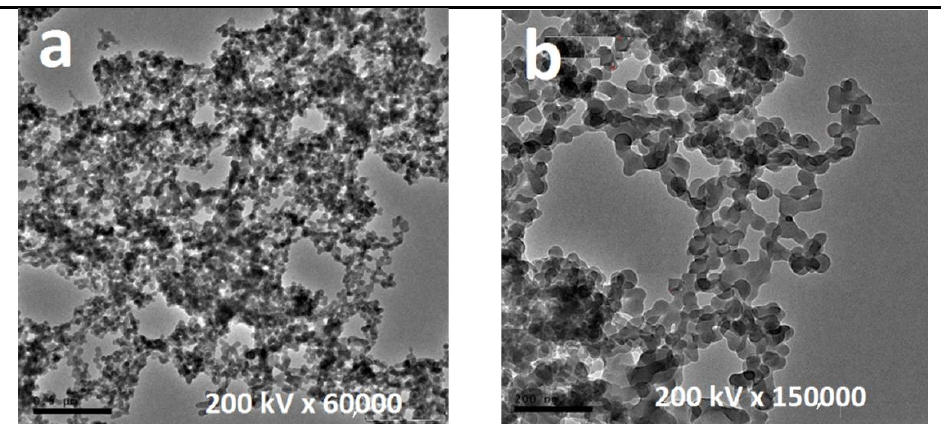
Figure 6. TEM graphs of the selected metal oxide nanoparticles (nMO x = ( a )WO 3 /( b )ZnO)